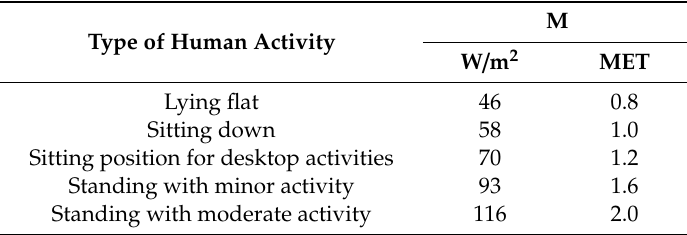
Table 1. Human metabolism quantitative reference [26].